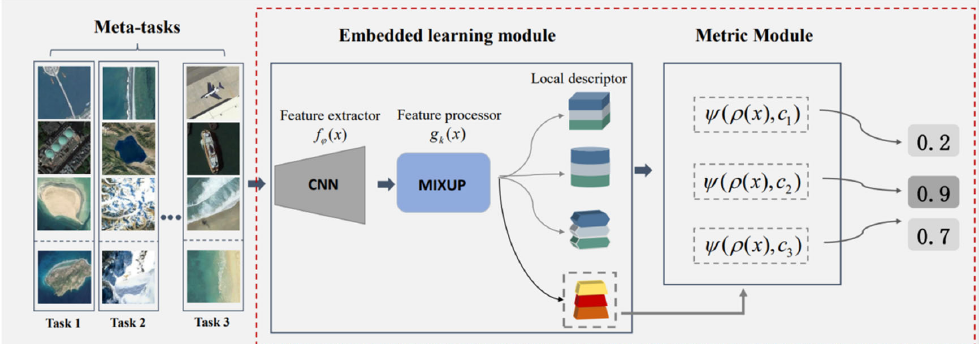
Figure 2. Model framework based on metric learning and local descriptors.